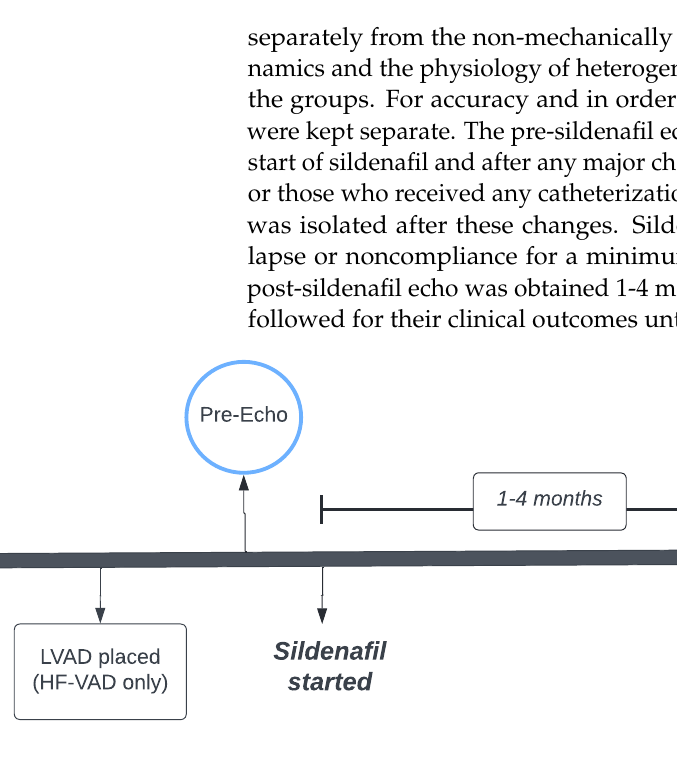
Figure 2. Patient study